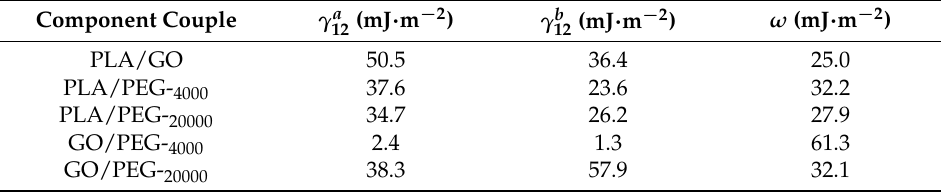
Table 3. The values of component couple surface energies and binding energies of the samples.